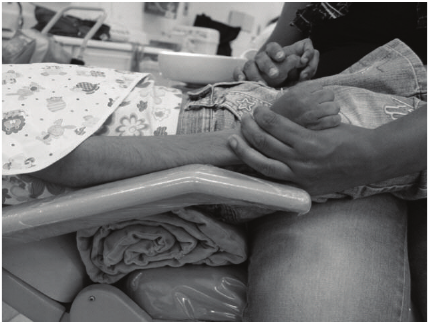
Figure 5: Containment of the child by the mother during the dental